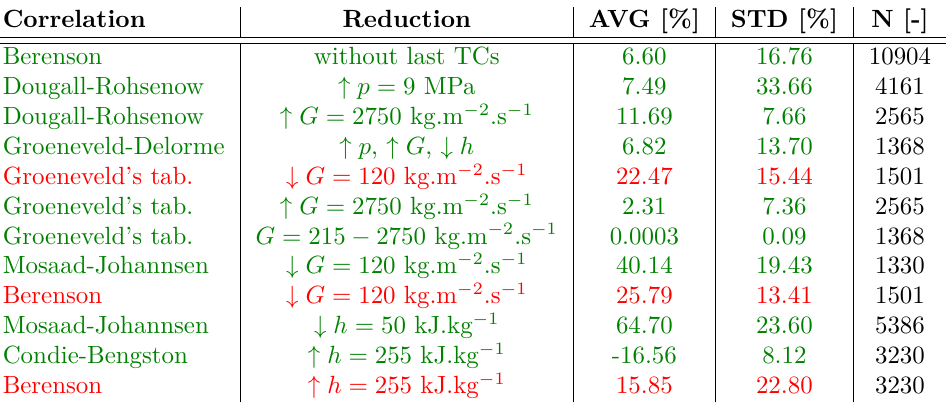
Table 5. Statistic analysis of correlations compared with Stewart’s experimental data with specific reductions. Green colour stands for improvement and red for